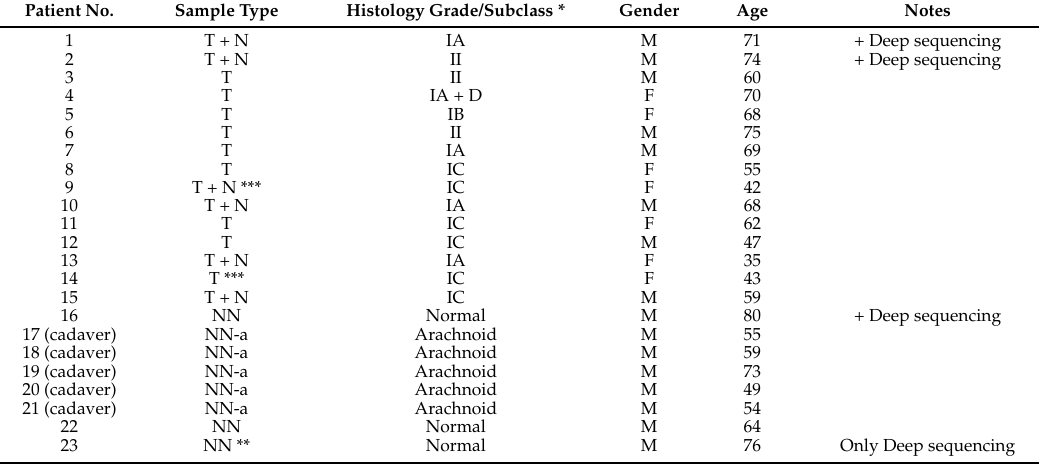
Table 1. List of meningiomas used for RNA isolation for SOLiD small RNA sequencing and for the validation of miRNAs and mRNA expression studies by RT-qPCR, as well as IHC analysis. Patient No.